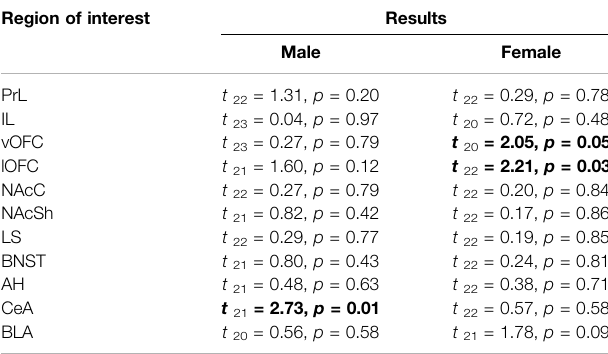
TABLE 4 | Independent samples t-test results for social stimulus associated β -gal labeling between adolescent exposure conditions (water; AIE) within each region of